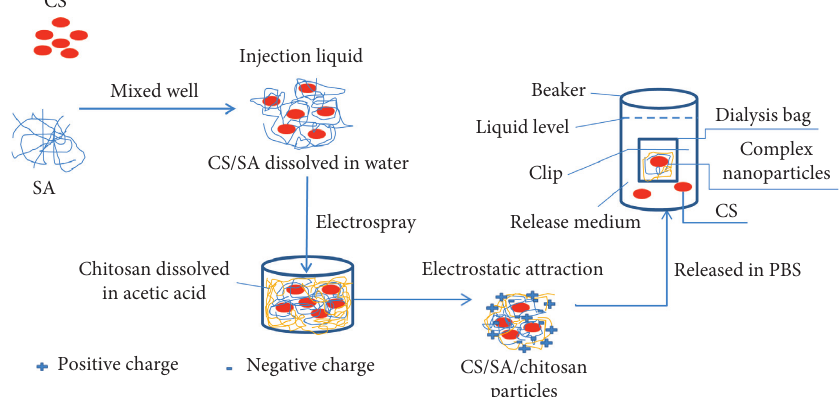
Figure 1: The schematic diagram of nanoparticle assembly and encapsulation and release of